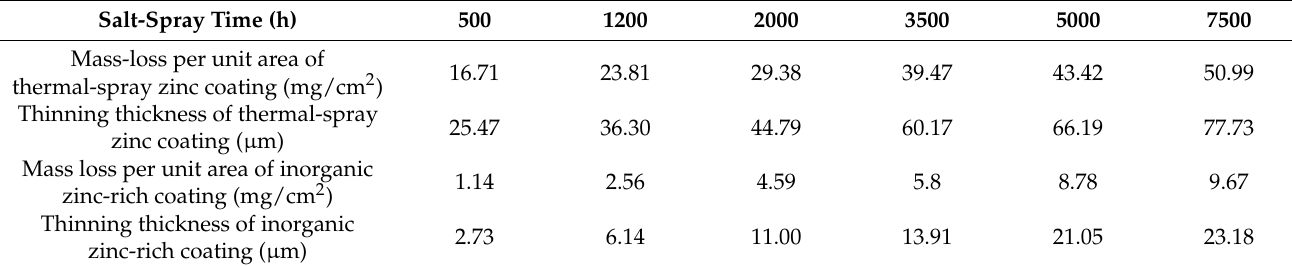
Table 3. Weight-loss data and thinning thickness of the zinc